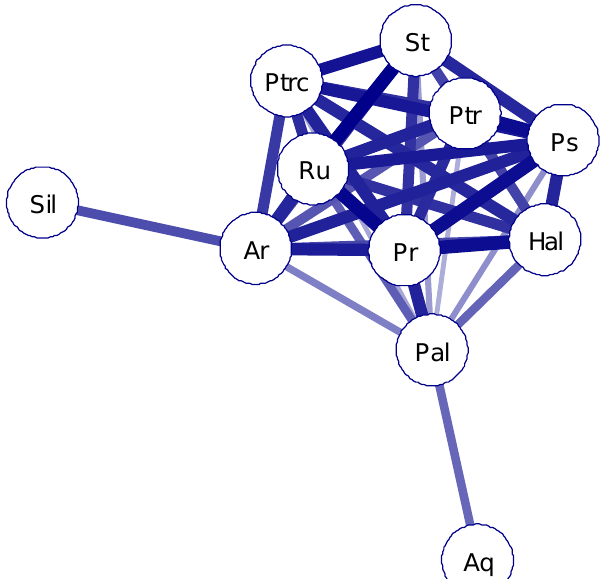
Рис. 2. Граф подобия между центроидами ценоморф в дискриминантном пространстве (подобие обратно дистанции Махаланобиса и нормировано к диапазону 0–1, где 1 – максимальное подобие; показаны подобия больше 0,5)